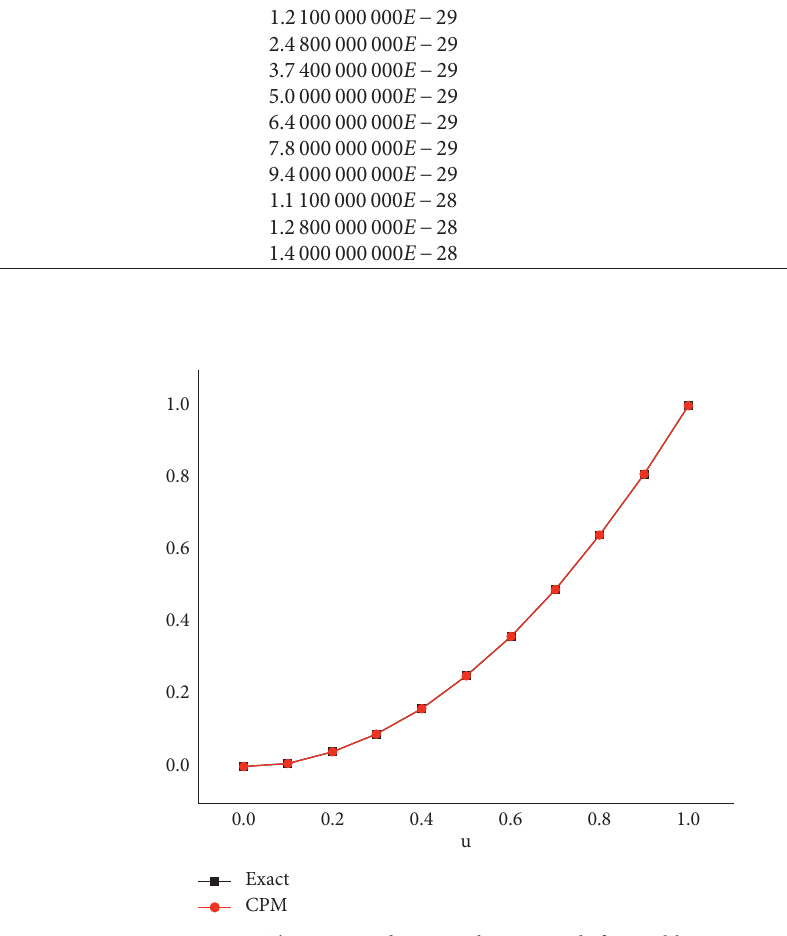
Figure 7: The exact and CPM solution graph for problem